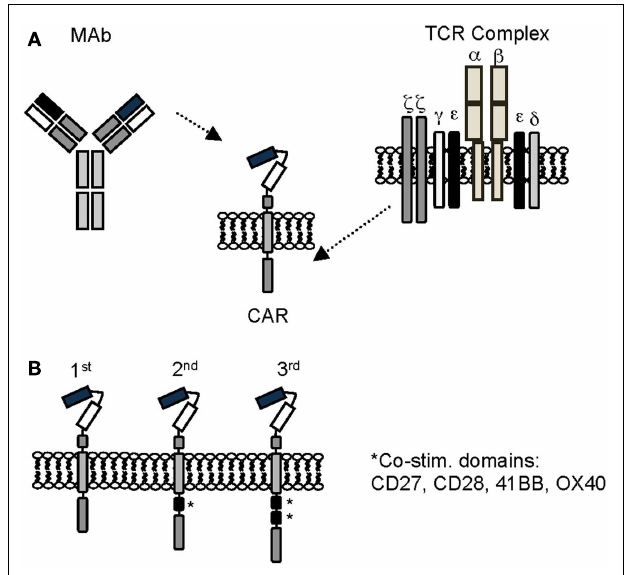
FIGURE 1 | Chimeric antigen receptors . (A) Scheme of prototypic CAR. (B) First, second, and third generation CARs. See text for